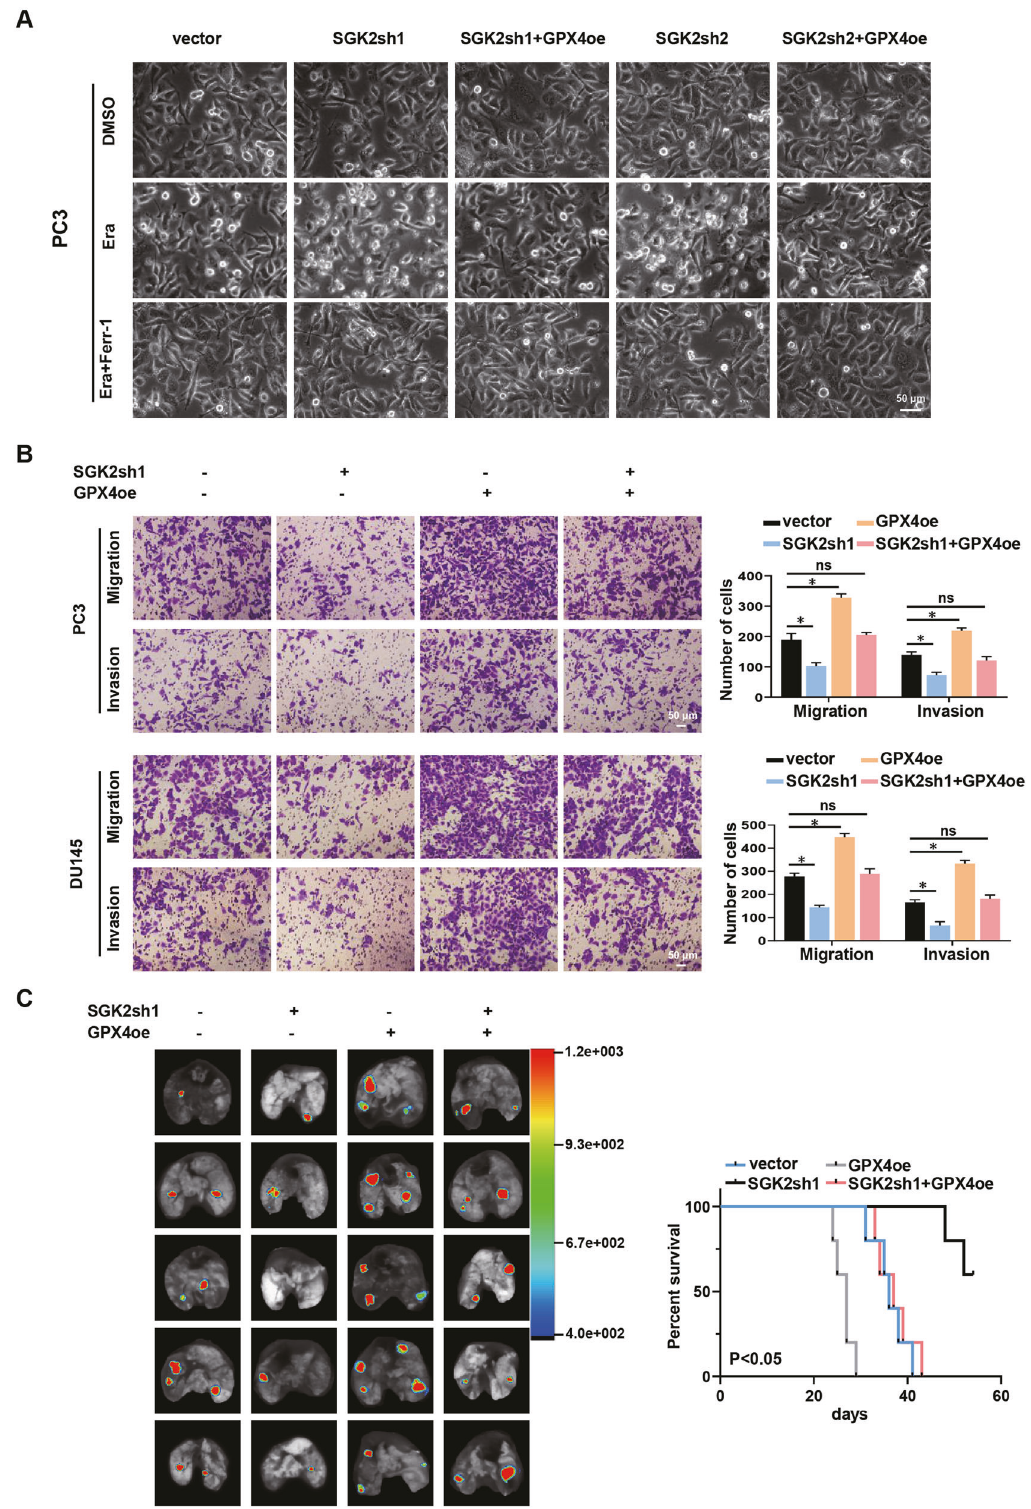
Fig. 4 GPX4 rescues the progression of SGK2 knockdown in PCa cells. A Representative phase-contrast images of PC3 cells with SGK2 knockdown, with/without GPX4 overexpression after treating with Era (5 μ M), Era (5 μ M) and Ferr-1(5 μ M) for 24 h. Scale bars, 50 µm. B Transwell analysis of the migration and invasion capability of PCa cells stably transfected as indicated. Scale bars, 50 μ m. C Left panel, representative bioluminescent image of metastatic lung colonization in nude mice injected with corresponding cells via tail vein. Right panel, Kaplan – Meier curves for nude mice in the metastasis assay. Data are presented as representative images or as the mean ± SD of three independent experiments. * P < 0.05; ns, not signi fi cant.